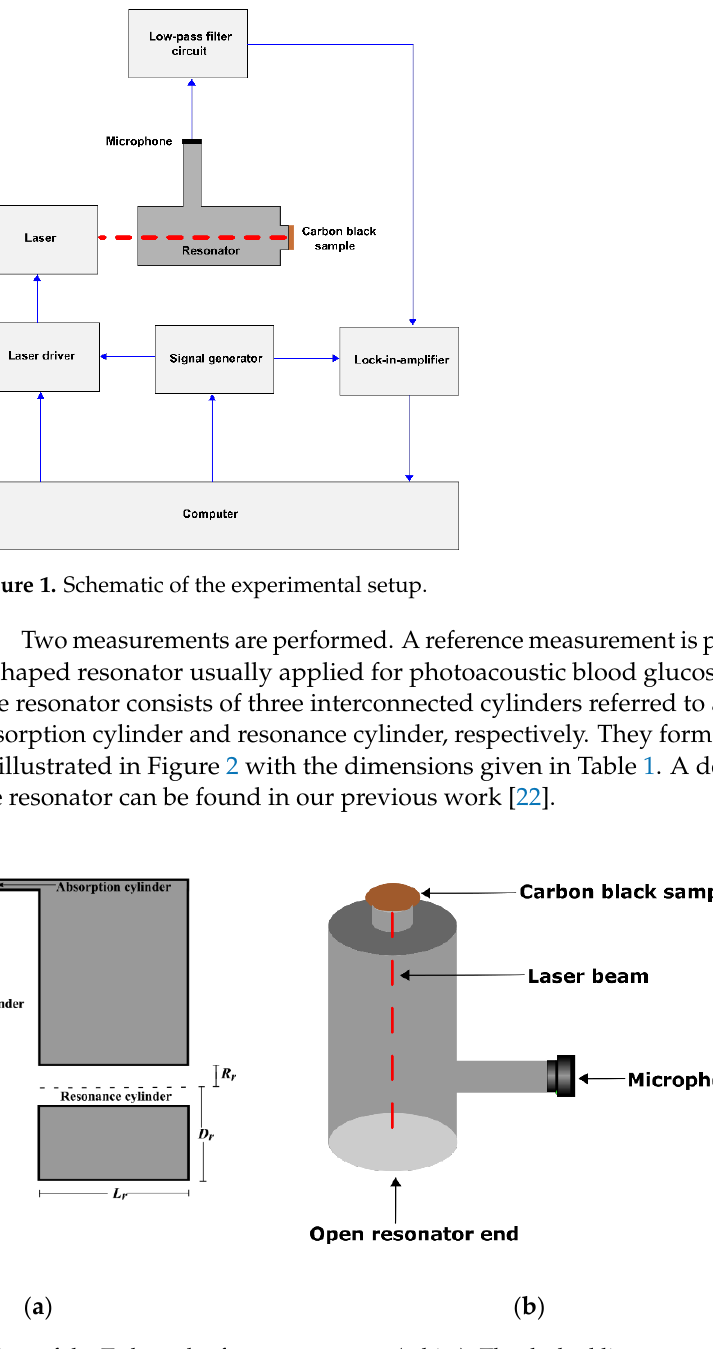
Figure 2. ( a ): Cross-sectional view of the T-shaped reference resonator (white). The dashed lines represent the cylindrical symmetry axes. ( b ): 3D view of the resonator. The resonator is rotated compared to the resonator depicted in the schematic of the experimental setup (Figure 1). Table 1. Resonator dimensions.